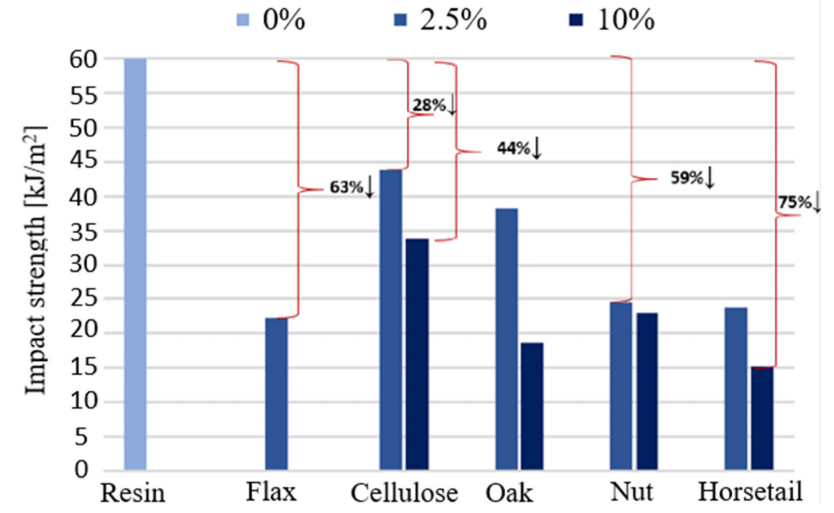
Figure 16. Material impact strength determined by the Charpy